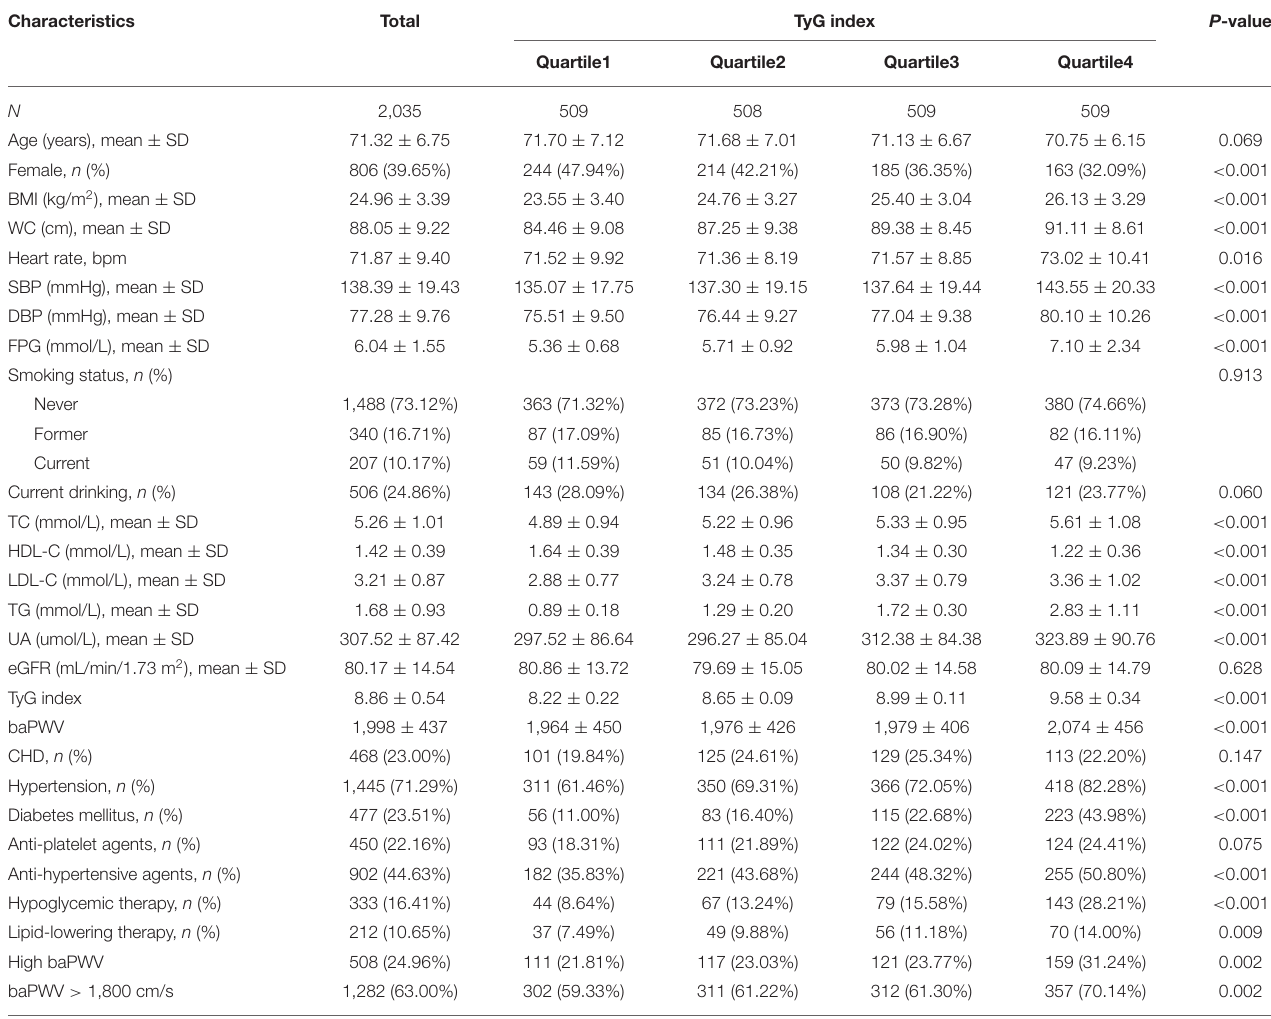
TABLE 1 | Baseline characteristics of all participants according to TyG index quartile.